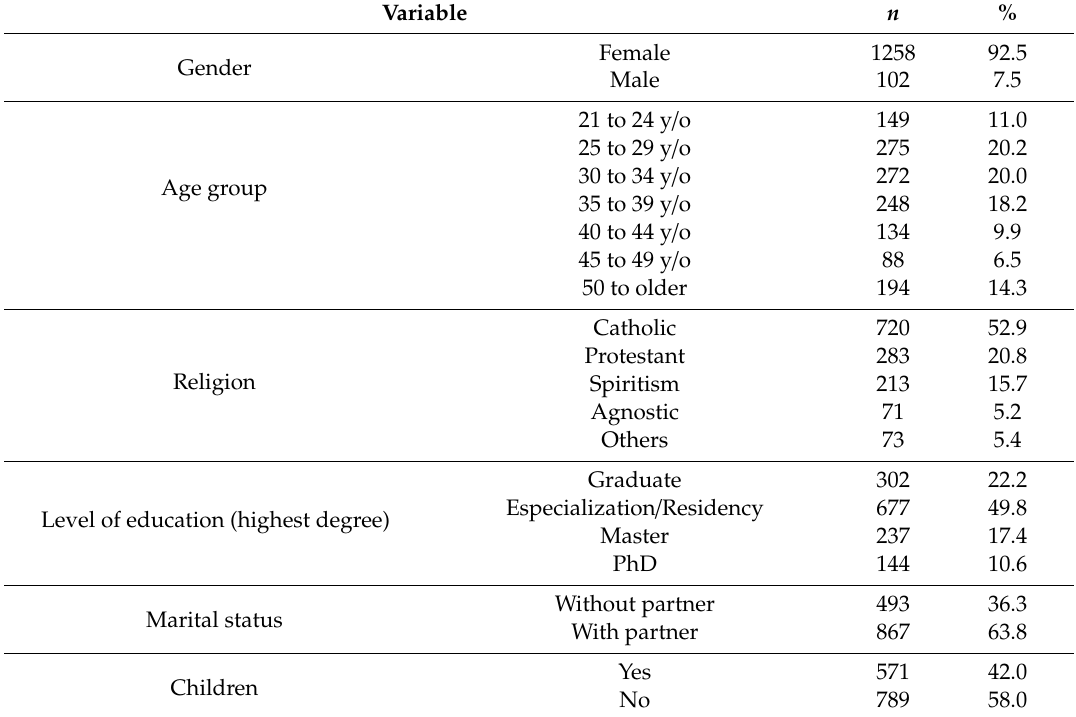
Table 1. Characteristics of Brazilian dietitians and SARS-COV-2 questions ( n = 1359).